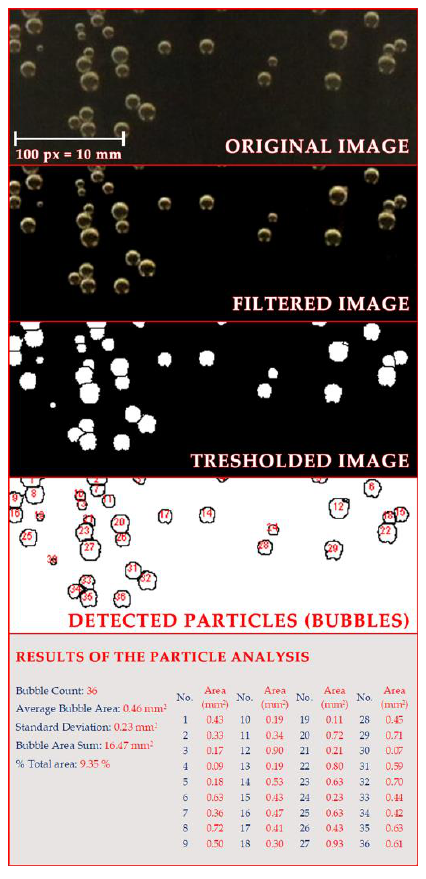
Figure 12. Bubble size determination in beer using digital image analysis method.